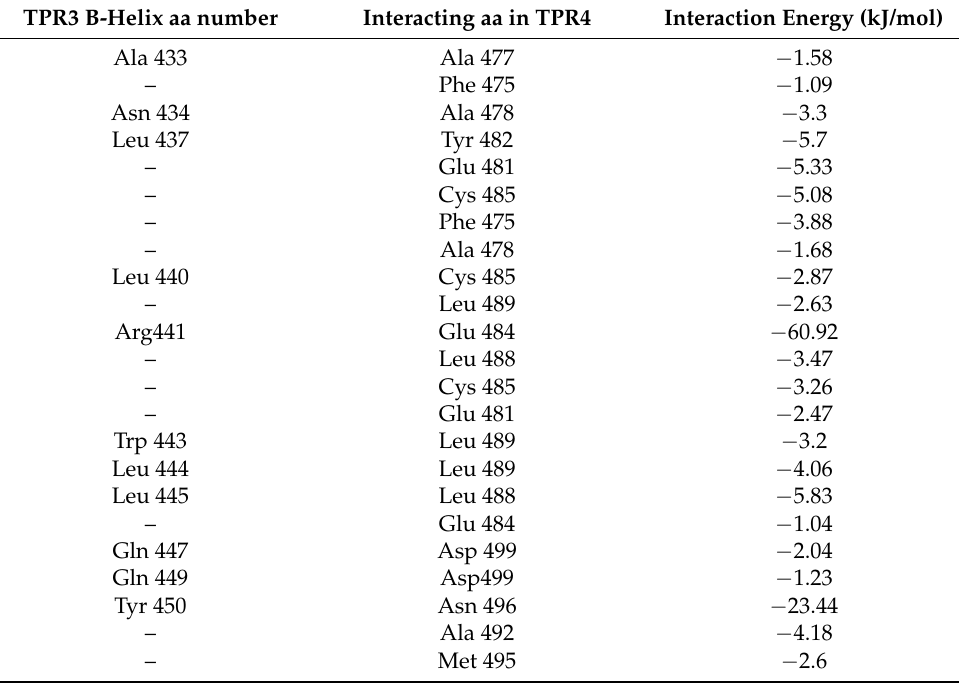
Table 1. Energy of side chain interactions between TPR4 and the B-helix of TPR3 in PDB